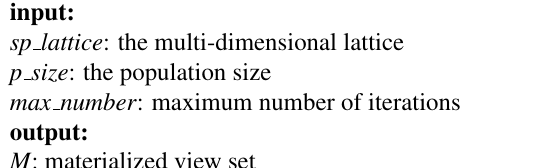
Table 4. The adaptive genetic algorithm for selecting material- ized views